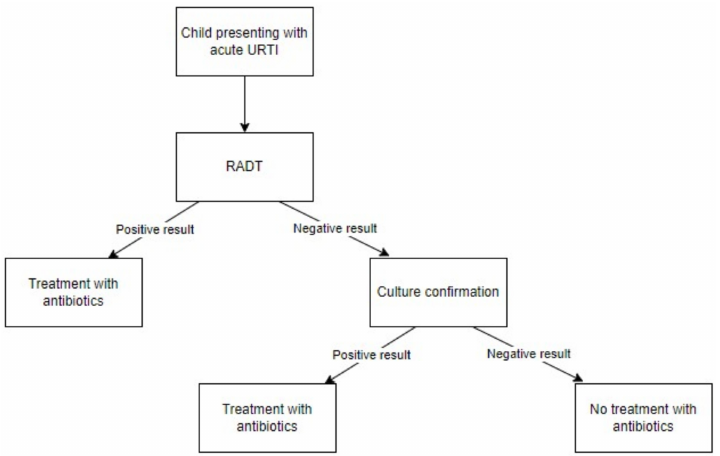
Figure 2. Flow chart summarizing the 2012 Infectious Diseases Society of America (IDSA) guidelines for managing group A streptococcal pharyngitis (GAS) [28]. RADT: rapid antigen-detection test; URTI: upper-respiratory-tract